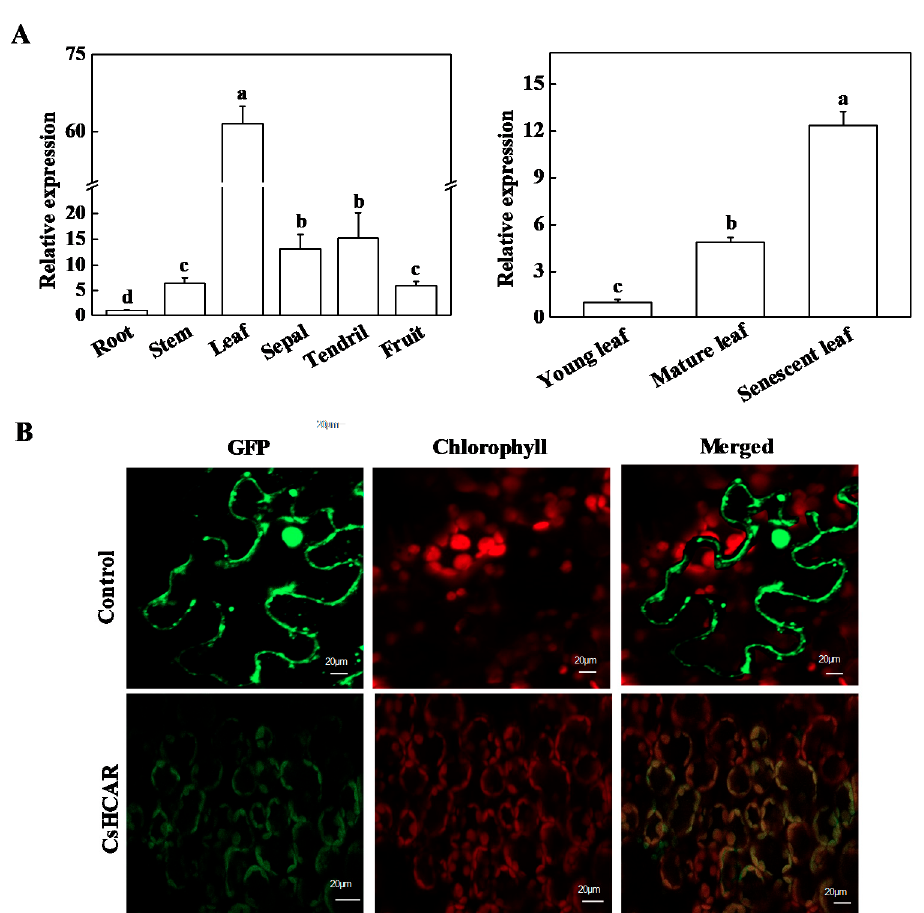
Figure 2. Expression patterns of CsHCAR in different tissues and its subcellular localization. ( A ) qPCR analysis of the expression of CsHCAR in roots, stems, leaves, fruits, sepals, and tendrils of cucumber. The expression level in roots or young leaf was set to 1.0. The results represent the mean ± SE ( n = 3). Means with the same letter did not significantly differ at p < 0.05 according to Tukey’s test. ( B ) Subcellular localization of CsHCAR in tobacco cells. Bars: 20 μ m.